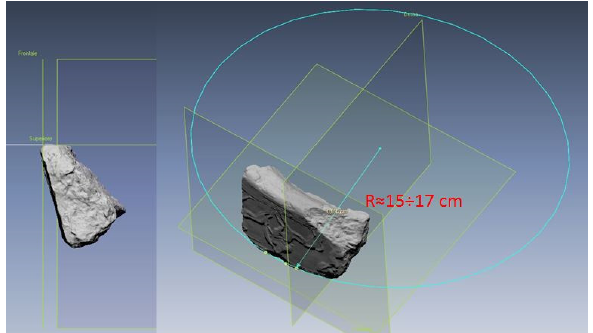
Figure 16. Orientation and estimated diameter of the fragment with Centauromachia scene.